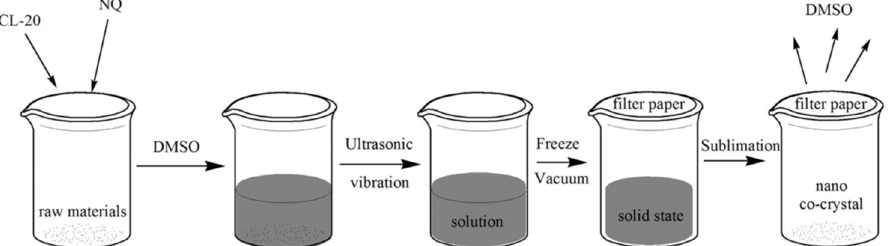
Figure 9. Illustration of the vacuum freeze ‐ drying method to prepare nano ‐ sized CL ‐ 20/NQ co ‐ crys ‐ tal. Reproduced from [78], with permission from Propellants Explos. Pyrotech., 2017.